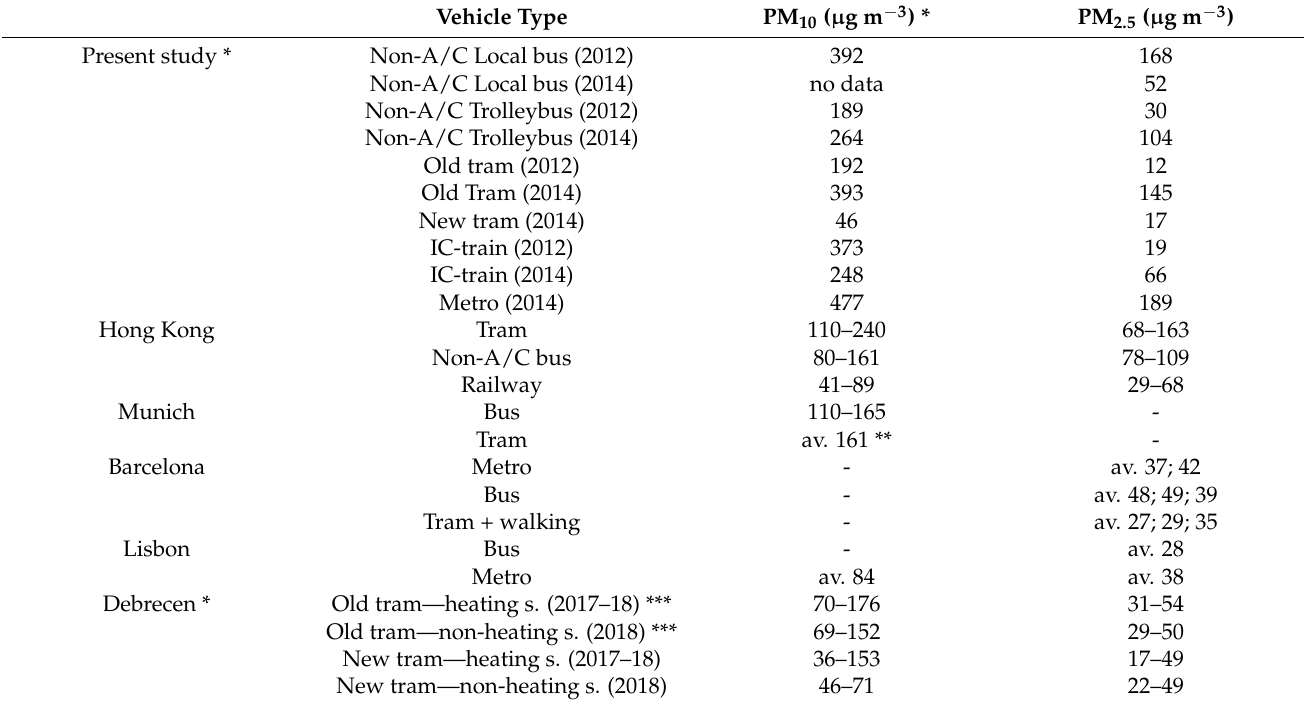
Table 3. Comparison of the PM 10 and PM 2.5 concentrations with other